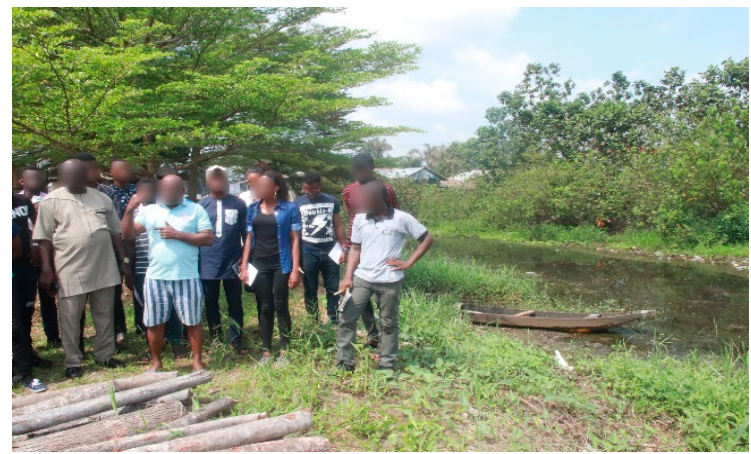
Figure 3. Workshop participants’ interactions with some of the residents and community leaders during the field visit.